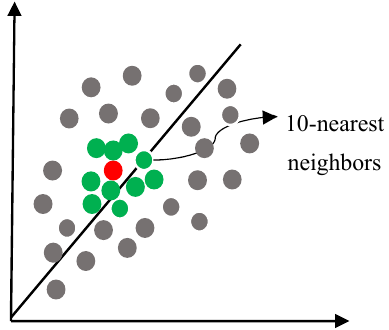
Figure A7. The introduction to K-nearest neighbors.